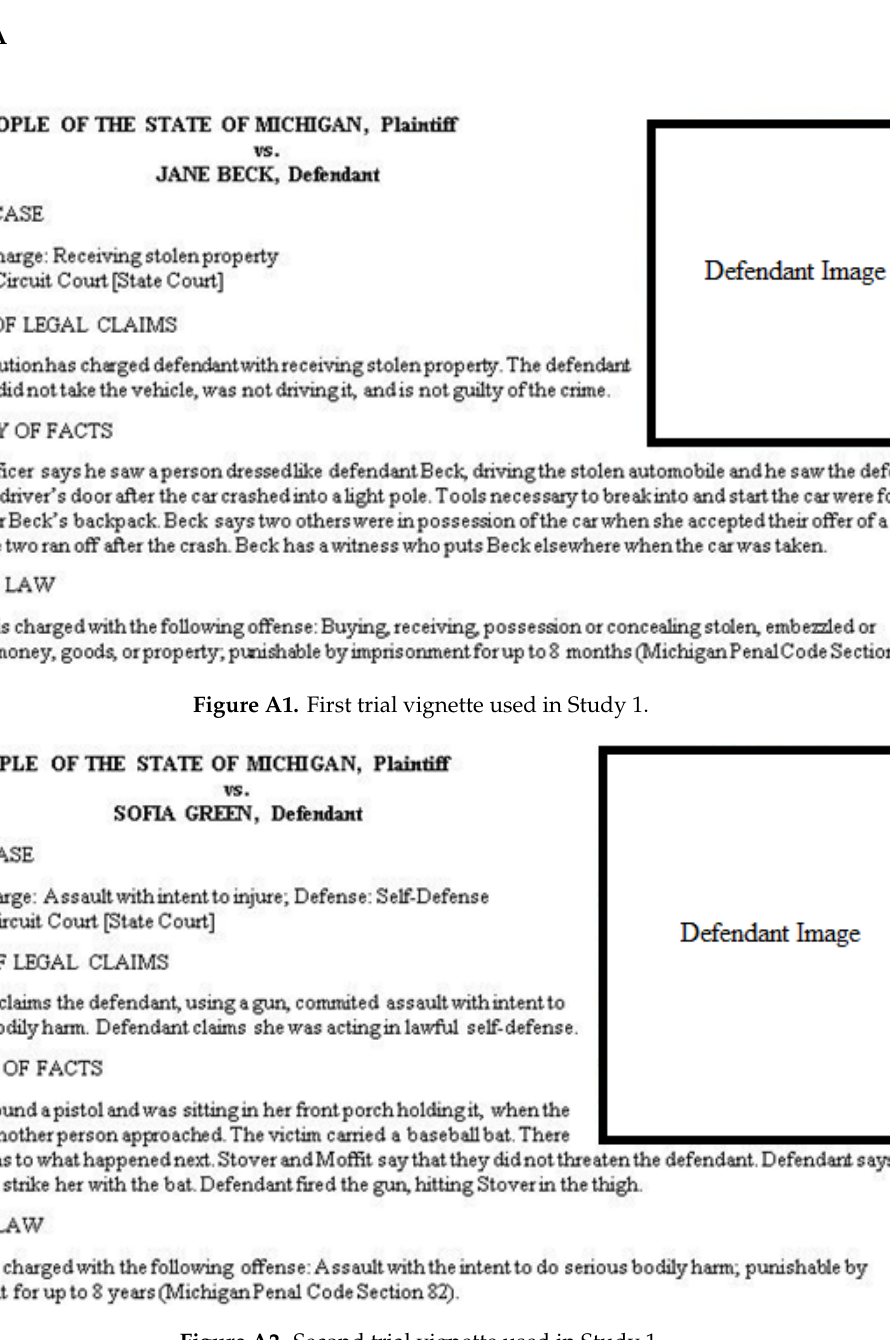
Figure A2. Second trial vignette used in Study 1.